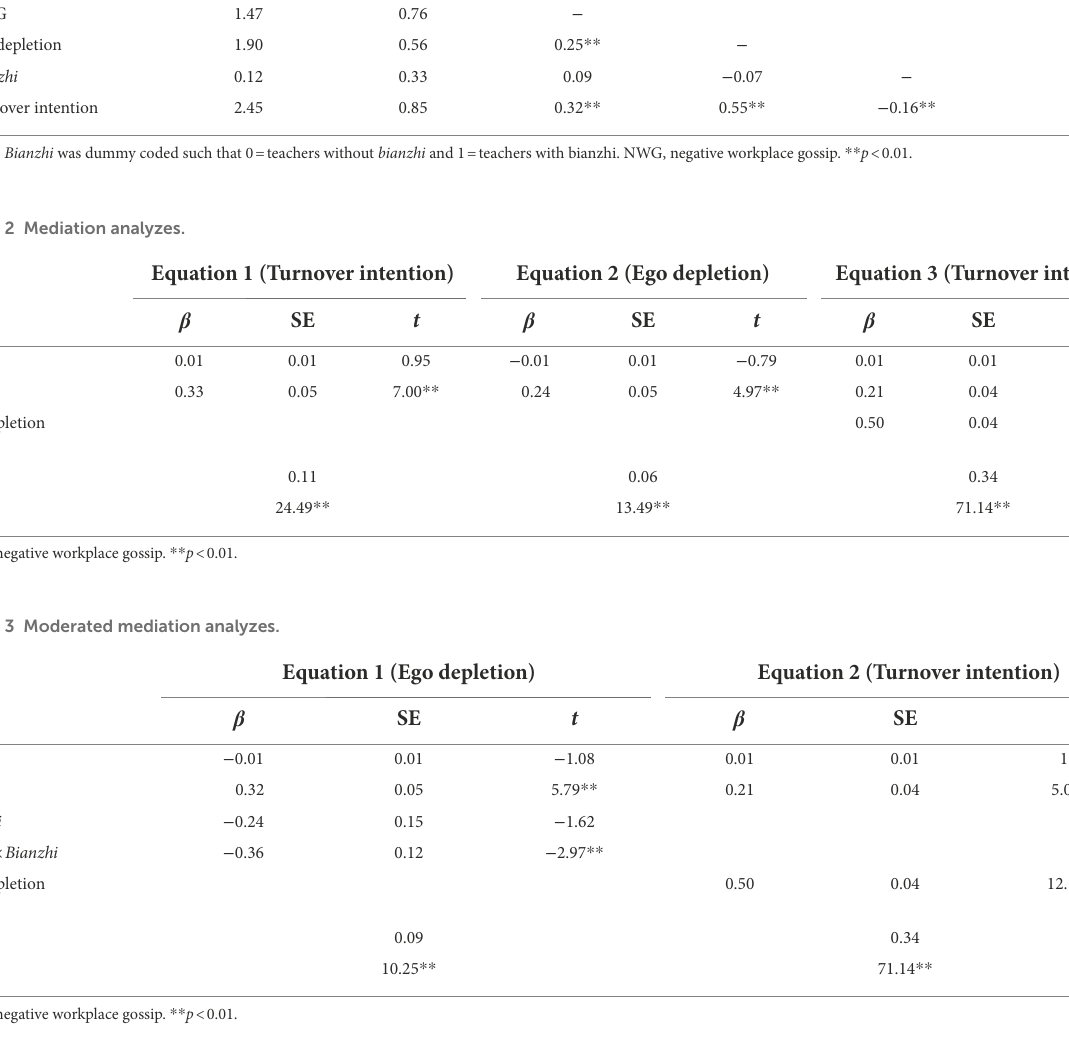
TABLE 1 Means, standard deviations and correlations for the main variables. Variable